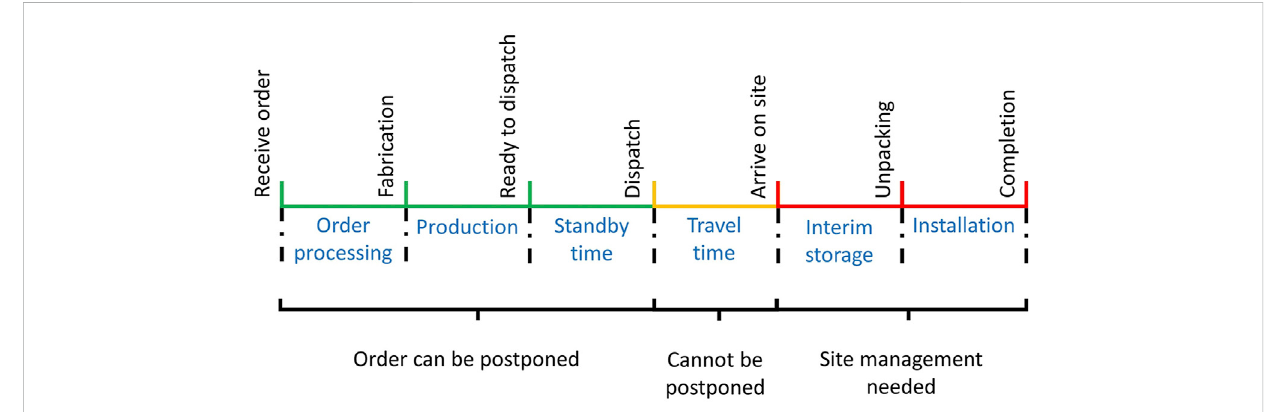
FIGURE 3 Stages of a building material in the construction supply chain (Cheng and Kumar,